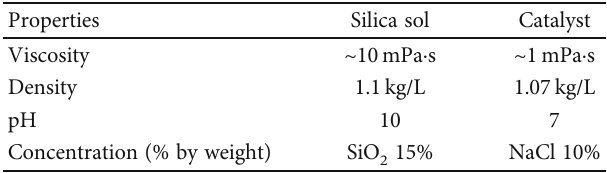
Table 2: Basic physical properties of silica sol and catalyst.